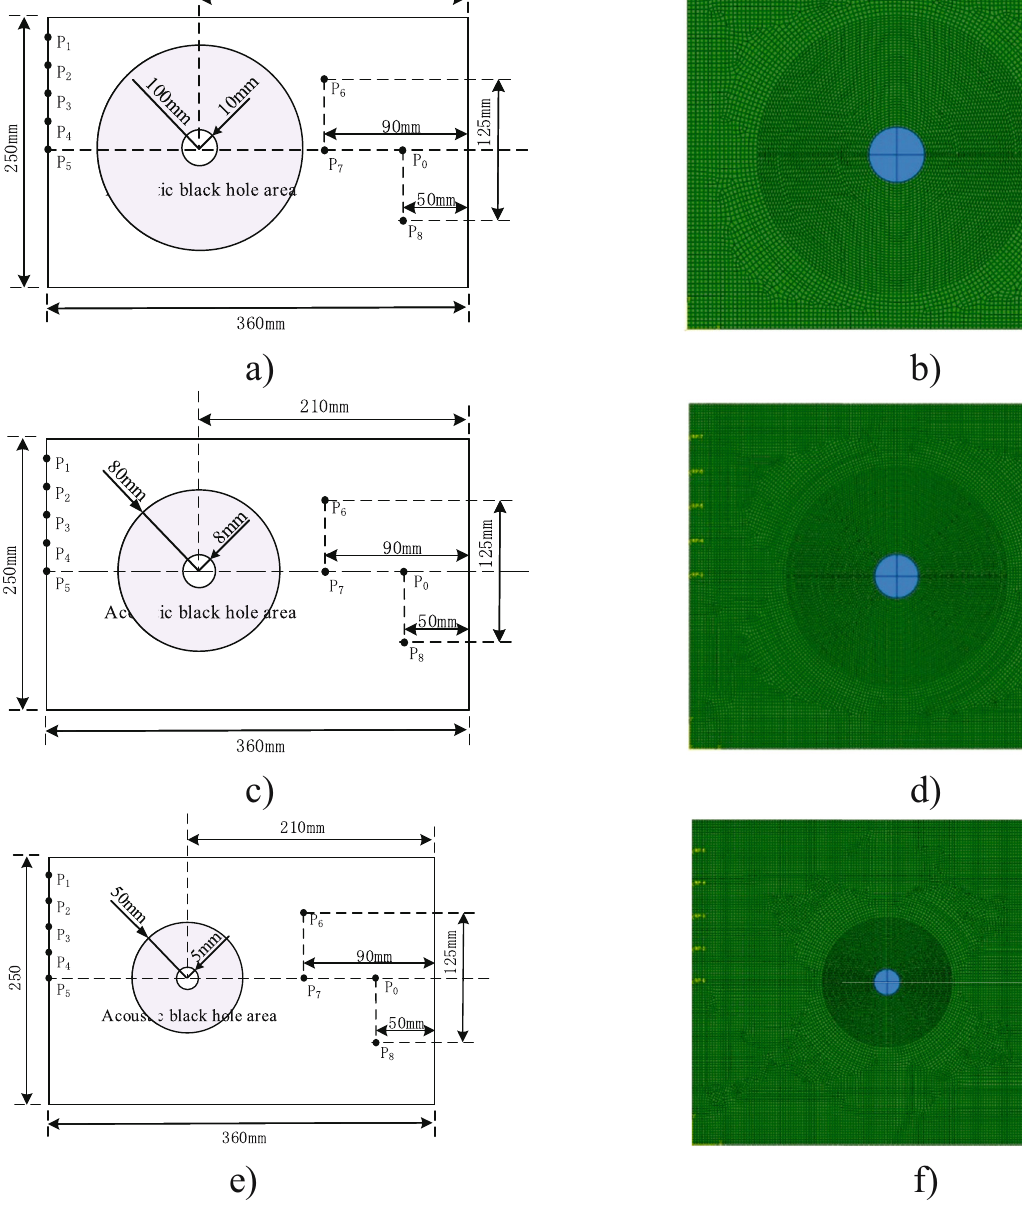
Figure 9: Acoustic black hole plate models with di ff erent sizes: ( a ) γ = 80% model diagram, ( b ) γ = 80% model diagram, ( c ) γ = 64% model diagram, ( d ) γ = 64% model diagram, ( e ) γ = 40% model diagram, and ( f ) γ = 40% model